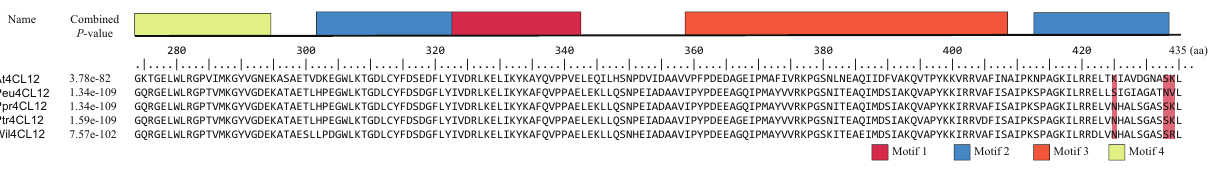
Figure 4. Positions of the positive selection sites. Sequence alignment of 4CL12 orthologs from 274–435 amino acid sites from five species included five motifs; the numbers and colors represent motifs 1–4. The three positive-selection sites predicted by the branch-site model test are colored red. Two sites (alignment positions 425 and 433) were located in motif 2. One site (alignment position 434) was located in none of the motifs. Table 4. Summary statistics for detecting selection using branch-site models in